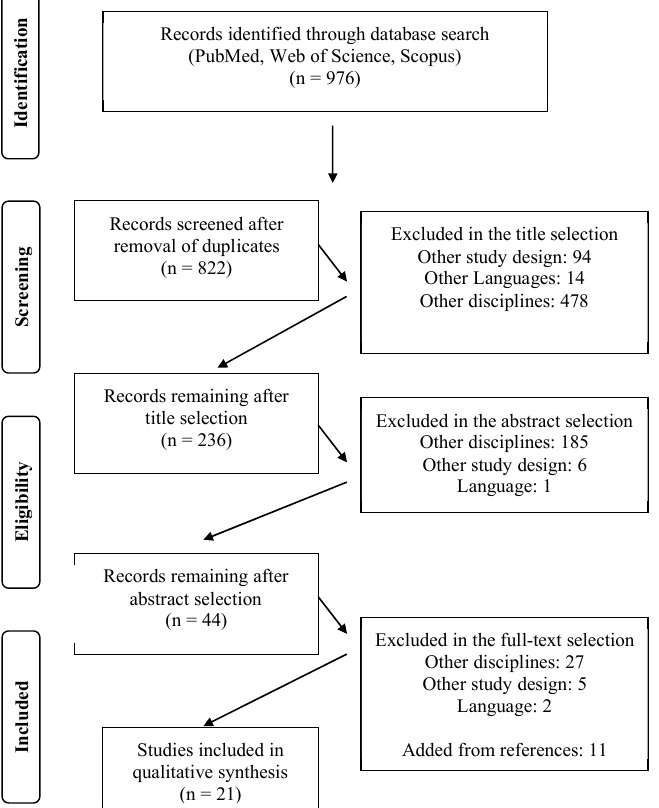
Figure 1. Flow chart of the selection criteria process of the included studies.